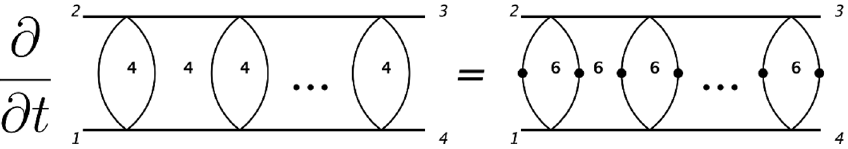
Figure 6 . Relation between the D = 4 and D = 6 ladder diagrams. Numbers in the diagram correspond to the dimensionality of loop